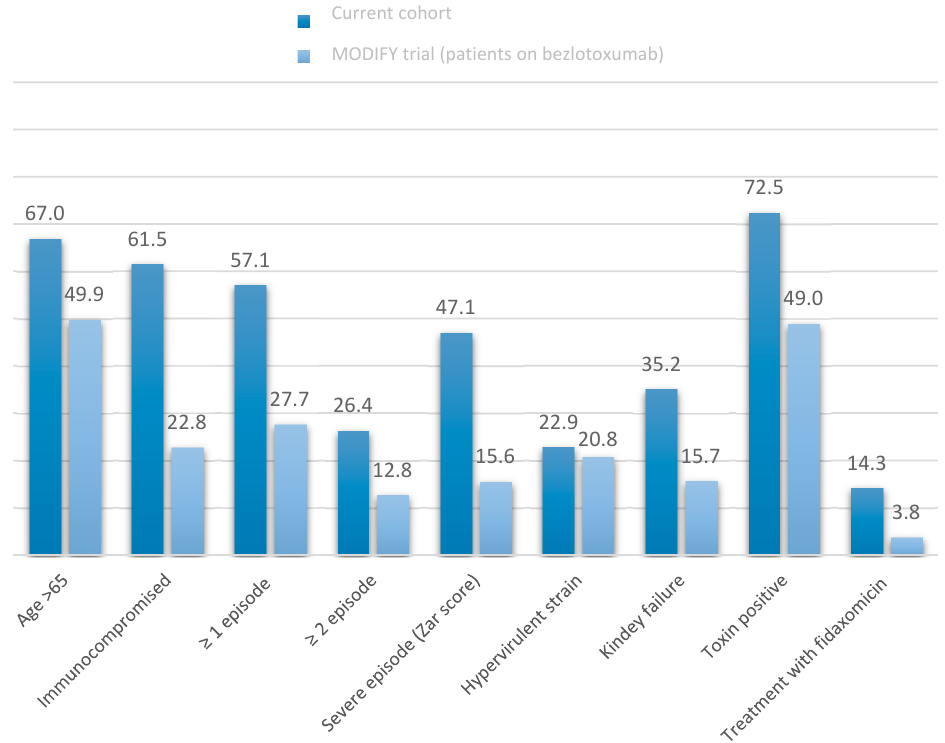
Figure 1. Comparison of variables in current cohort and bezlotoxumab-treated patients in MODIFY trial. Numbers show the percentage of patients.